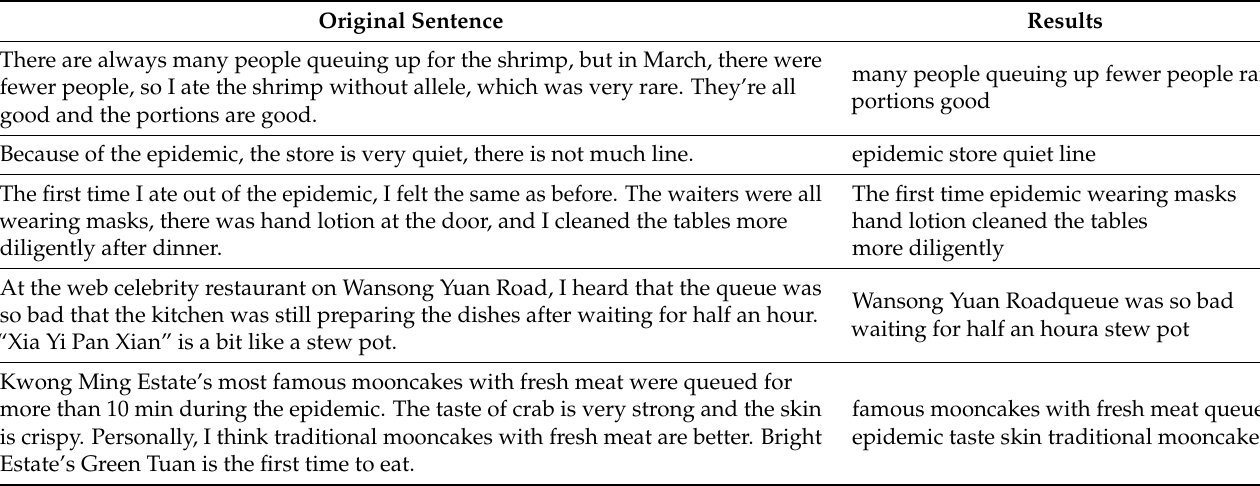
Table 3. Filtering